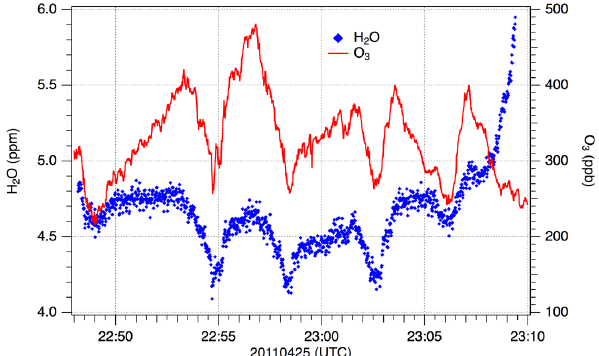
Fig. 13. Measured H 2 O mixing ratios (blue) on the flight on 25 April 2011 in the lower stratosphere (13.9–16.9km) showing the excellent measurement precision at low mixing ratios. Also shown are coincident O 3 mixing ratios (red) measured by the NOAA O 3 instrument that display a correlated structure to that observed in H 2